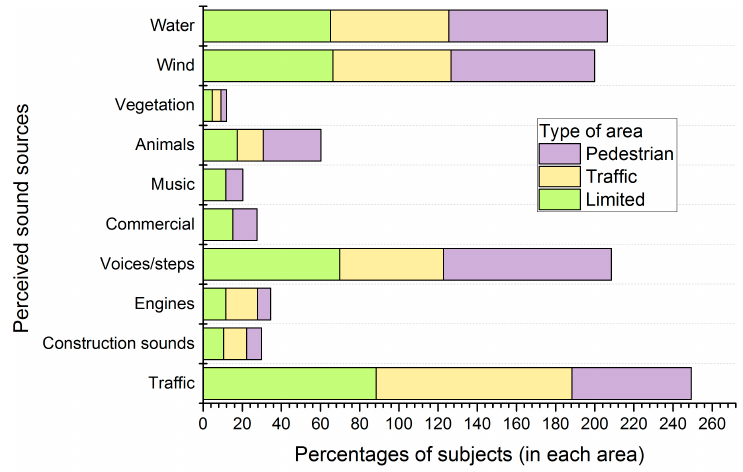
Figure 3. Percentage of subjects that recognized a certain sound source within the three types of areas a priori classified as pedestrian areas, open to road traffic areas and limited traffic areas.